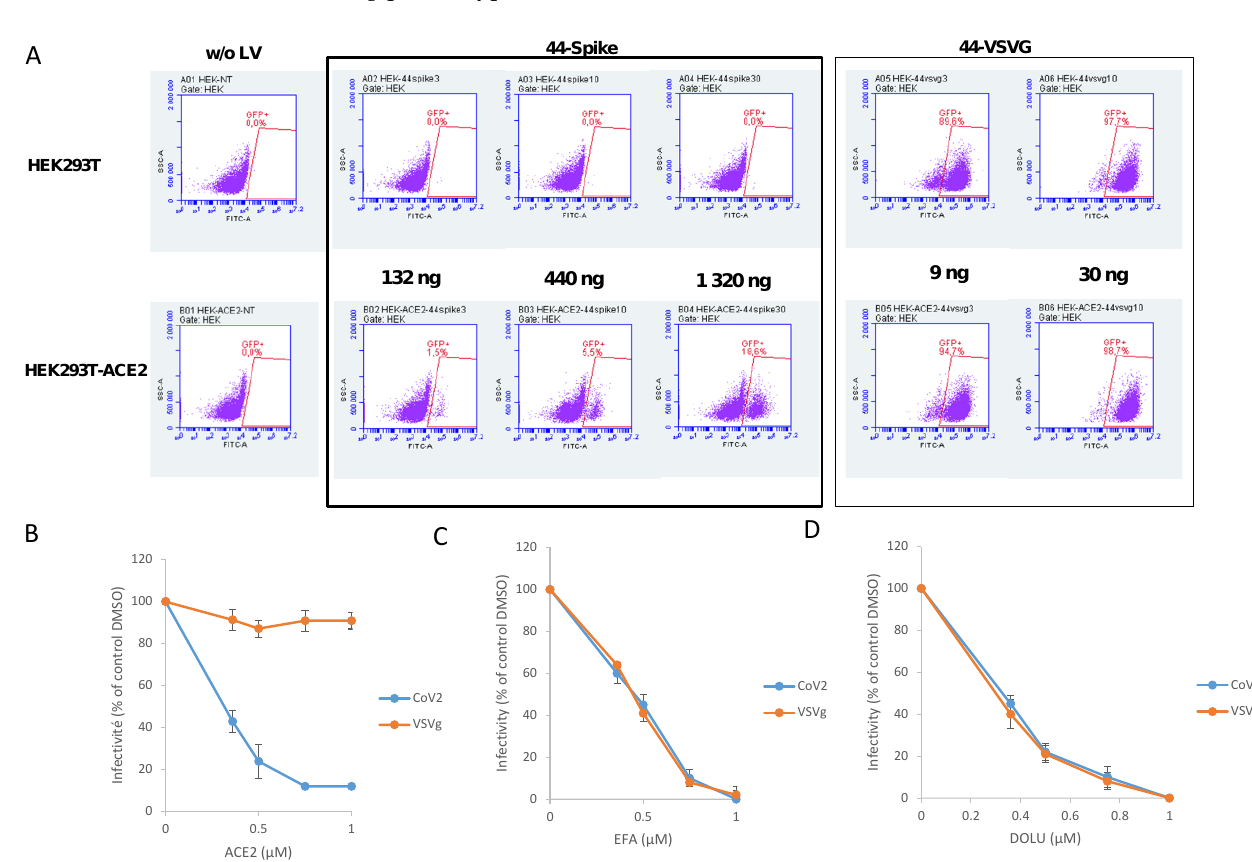
Figure 4. VSVg and SARS-CoV-2 pseudotyped lentiviruses infectivity assay. HEK293T and HEK293T-ACE2, generated as described in the materials and methods section, were transduced with lentiviral vectors peseudotyped with SARS-CoV-2 S protein (44-spike) or VSVg protein (44-VSVg) using different quantities of viral particles reported in the figure as ng of p24. Infectivity has been evaluated by eGFP-positive cells quantification by flow cytometry ( A ). Competition experiments have been performed using soluble ACE2 protein added simultaneously to the lentiviral vectors ( B ). Efavirenz, inhibitor of retroviral reverse transcription steps, and Dolutegravir, inhibitor of the integration step of retroviral replication, have been added simultaneously to VSVg and CoV-2 lentiviral vectors (respectively C , D ). Data were obtained from at least three independent experiments and are reported as means ±SD.